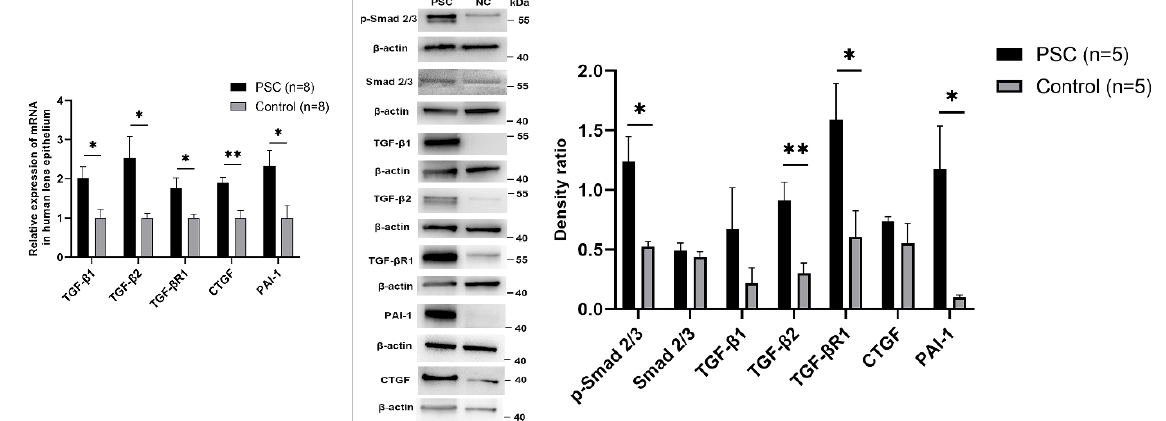
Figure 3. TGF- β /Smads signalling activated in lens of PSC patients. ( A ) The mRNA levels of TGF- β 1, TGF- β 2, TGF- β R1, CTGF and PAI-1 in human lens epithelial cells based on RT-qPCR analyses ( p = 0.015, 0.014, 0.023, 0.002 and 0.027, respectively). ( B ) The protein expression of TGF- β 1, TGF- β 2, TGF- β R1, CTGF, PAI-1, Smad2/3 and p-Smad2/3 ( p = 0.261, 0.008, 0.040, 0.321, 0.040, 0.487 and 0.017, respectively) based on Western blotting. * p < 0.05, ** p < 0.01.